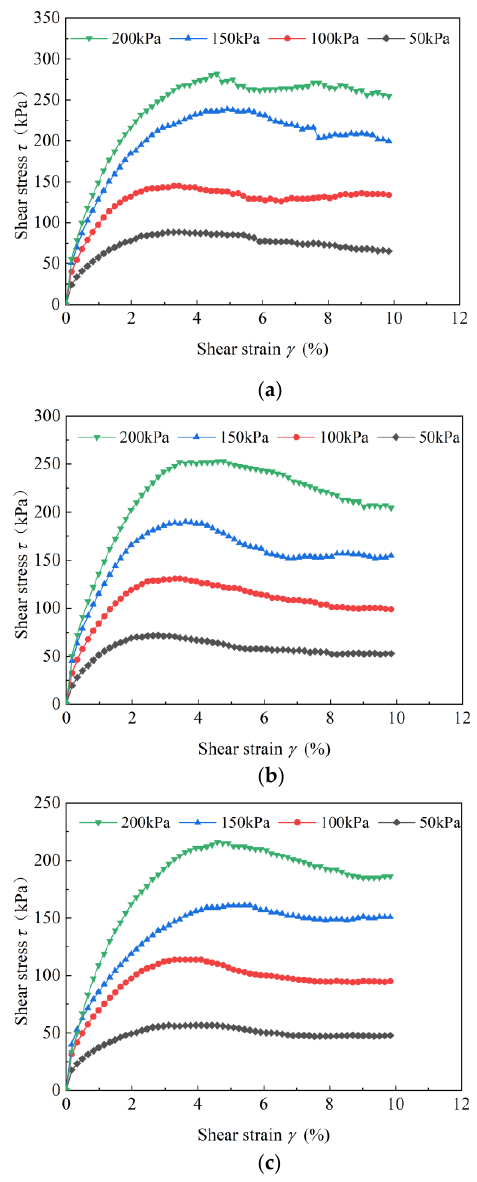
Figure 6. Relationship of shear stress and strain. ( a ) S = 0.581, d max = 40. ( b ) S = 0.581, d max = 20. ( c ) S = 0.581, d max = 10.